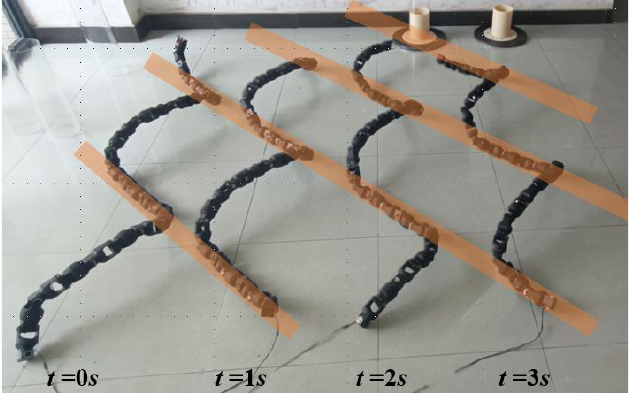
Figure 9. Implementation of snake robot with AEH-sidewinding gait. The figure shows the motion state of a snake robot at t = 0 s, t = 1 s, t = 2 s, and t = 3 s, respectively.